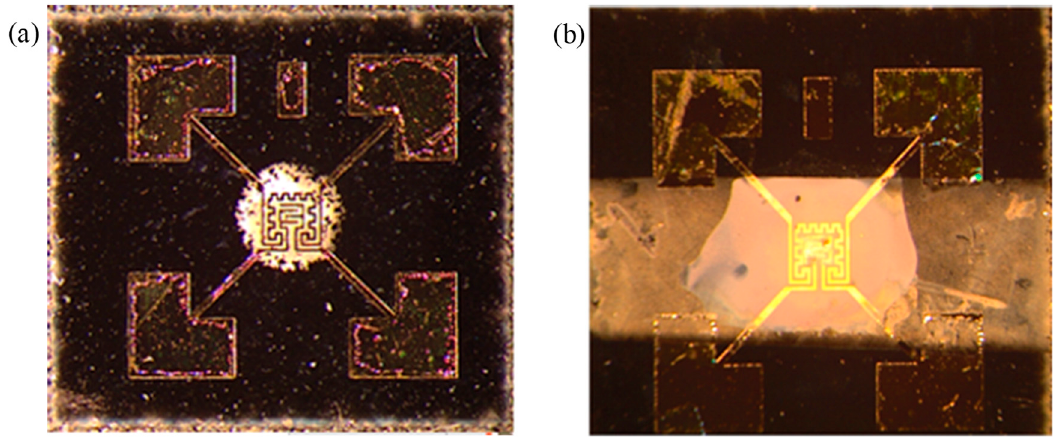
Figure 2. ( a ) Fabricated Micro Electro Mechanical System (MEMS) microheater and ( b ) ZnO nanosheets deposited microheater.